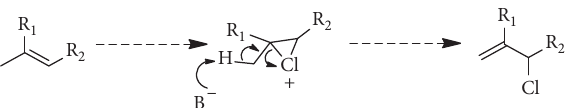
Scheme 3: Proposed mechanism of allylic chlorination of terpenic